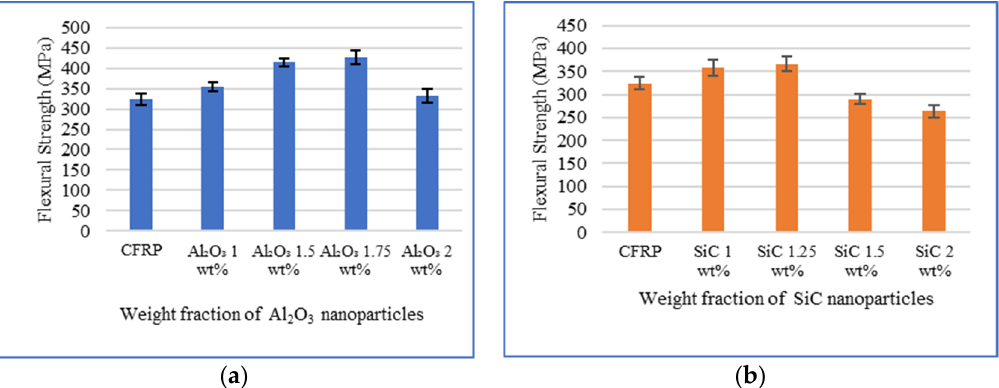
Figure 9. Flexural strength of neat and ( a ) hybrid Al 2 O 3 and ( b ) hybrid SiC nanocomposites at various weight fractions. Table 6. Flexural behavior of neat and hybrid Al 2 O 3 nanocomposites.